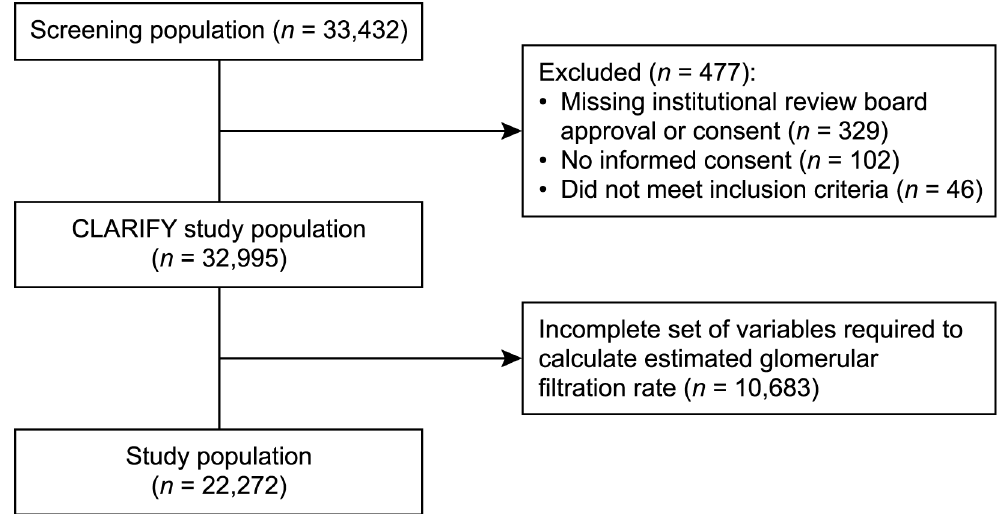
Figure 1. Patient flow chart.